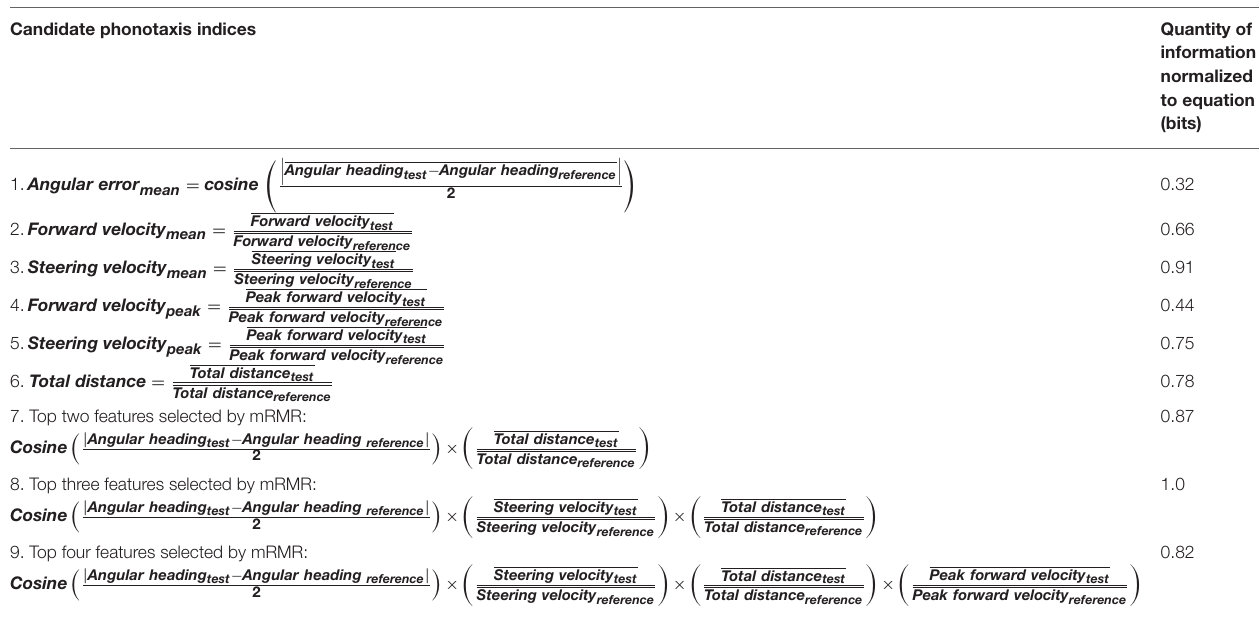
TABLE 2 | Evaluating candidate phonotaxis indices with mutual information analysis. Candidate phonotaxis